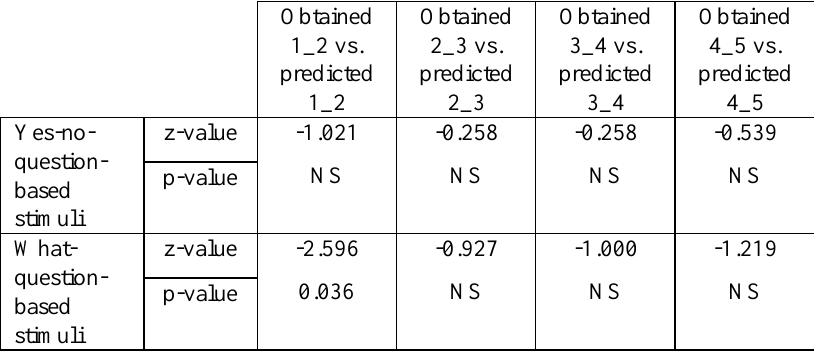
Figure 11. Predicted and obtained discrimination rates of the continuum created from the what-question base stimulus. Error bars represent the standard error of the mean.